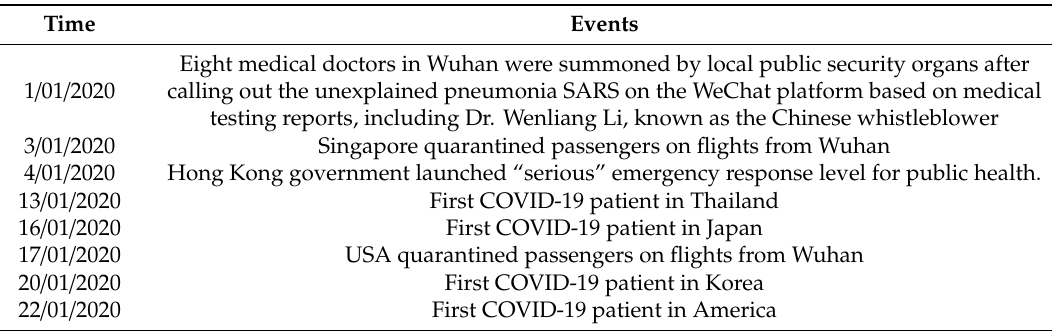
Table 2. Important time points to take preventative